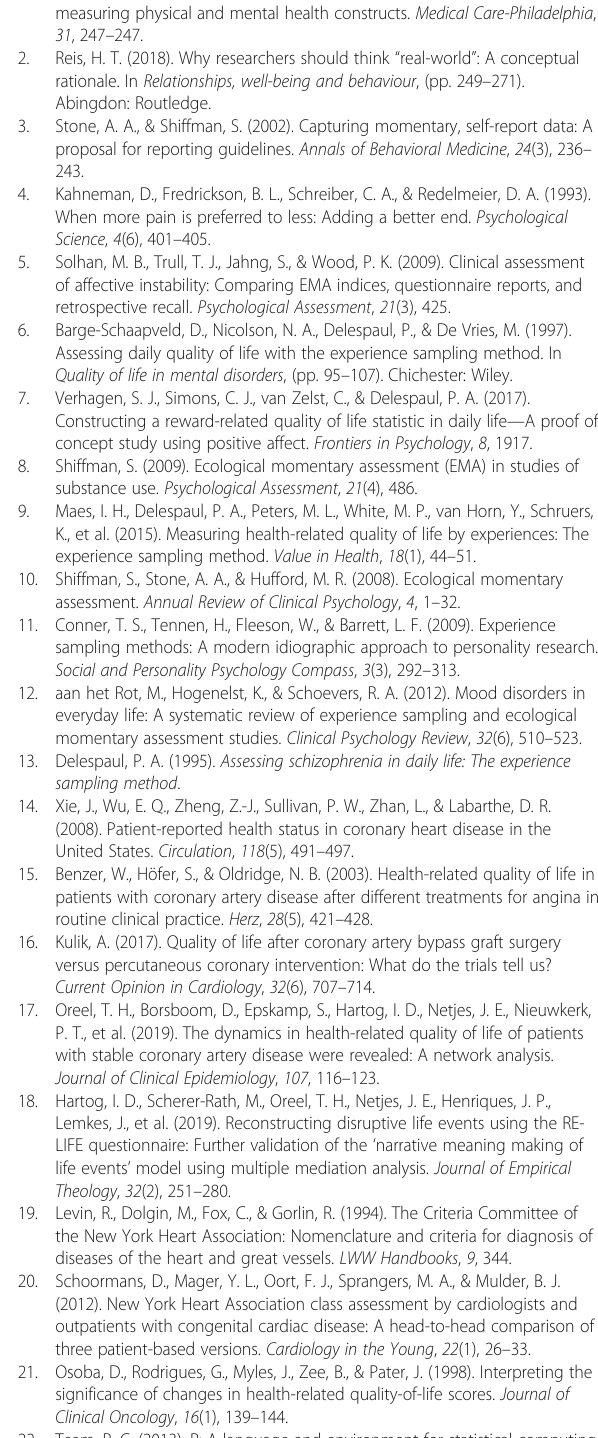
Table S5. Results of exploratory factor analysis of momentary HRQoL items at follow-up. Table S6. Results of exploratory factor analysis of the retrospective HRQoL items at baseline. Table S7. Results of exploratory factor analysis of the retrospective HRQoL items at follow-up. Additional file